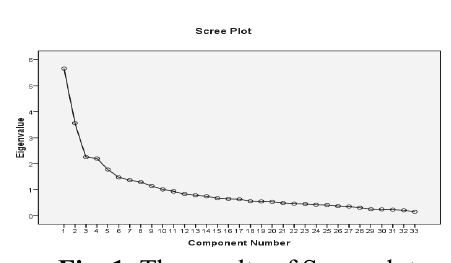
Fig. 1. The results of Scree plot